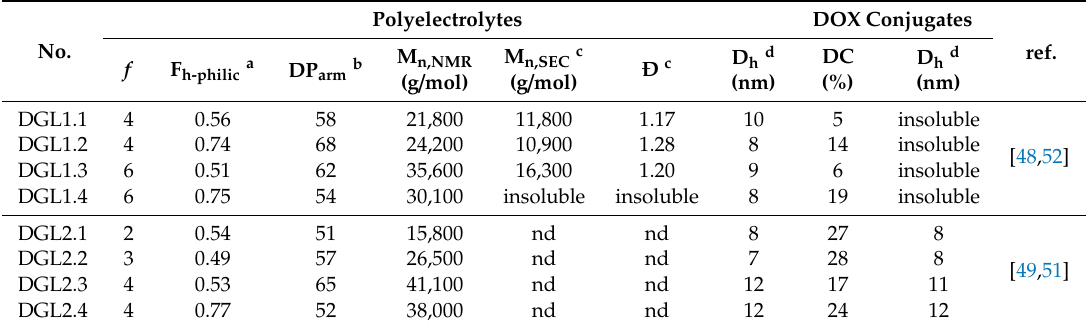
Table 2. Characterization of star-shaped polyacids DGL1 and polybases DGL2 (DDS type